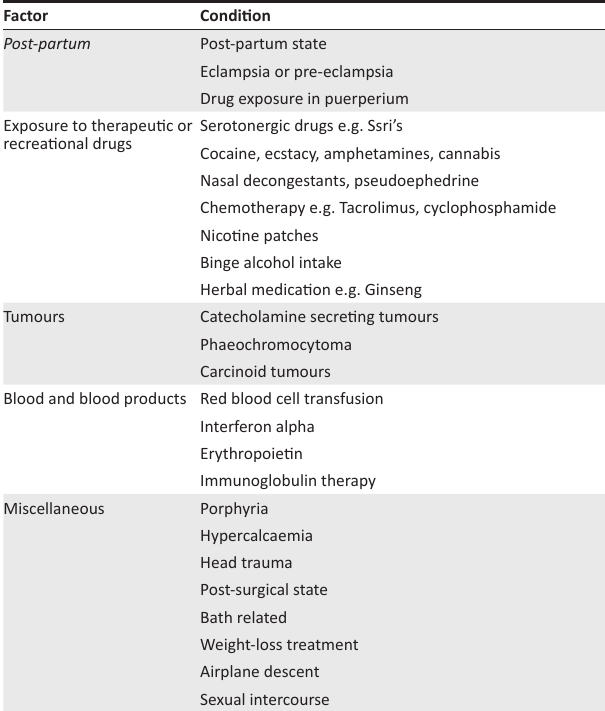
FIGURE 11: Corresponding axial PHASE MR images (a and b). TABLE 1: Precipitating factors and conditions associated with RCVS. TABLE 2: Causes of nonaneurysmal convexal SAH.